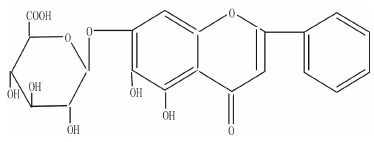
Figure 1. Chemical structure of baicalin.